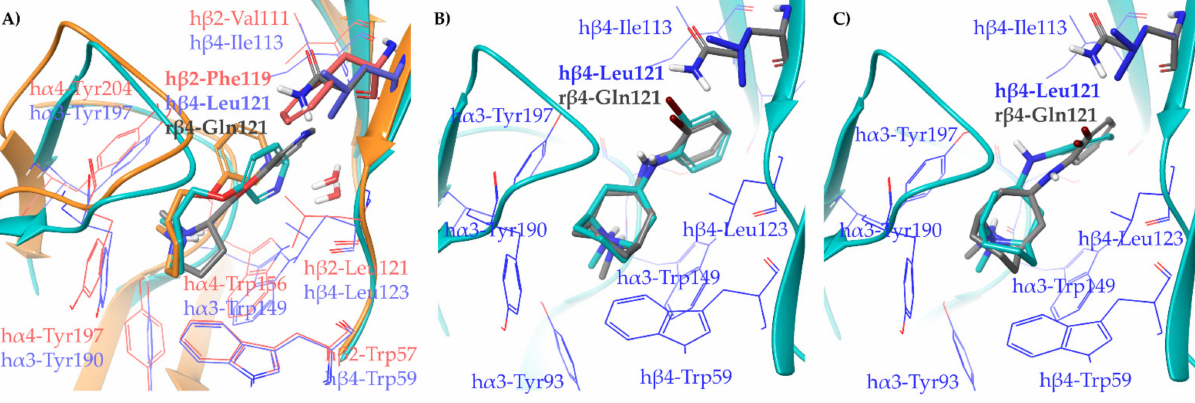
Figure 4. Receptor backbones are represented by orange (h α 4 β 2) or cyan ( α 3 β 4) cartoons. ( A ) Comparison between the proposed binding modes of A - 84543 at the h α 4 β 2 (PDB ID: 6CNJ, orange ligand and red residues), h α 3 β 4 (PDB ID: 6PV7, cyan ligand and blue residues), and at the r α 3 β 4 (grey ligand and residue). ( B ) Comparison between the original cryo-EM binding mode of AT - 1001 at the AB interface of h α 3 β 4 (PDB ID: 6PV8, cyan ligand and blue residues) with the docked binding pose at the r α 3 β 4 (grey ligand and residue) and ( C ) at the DE